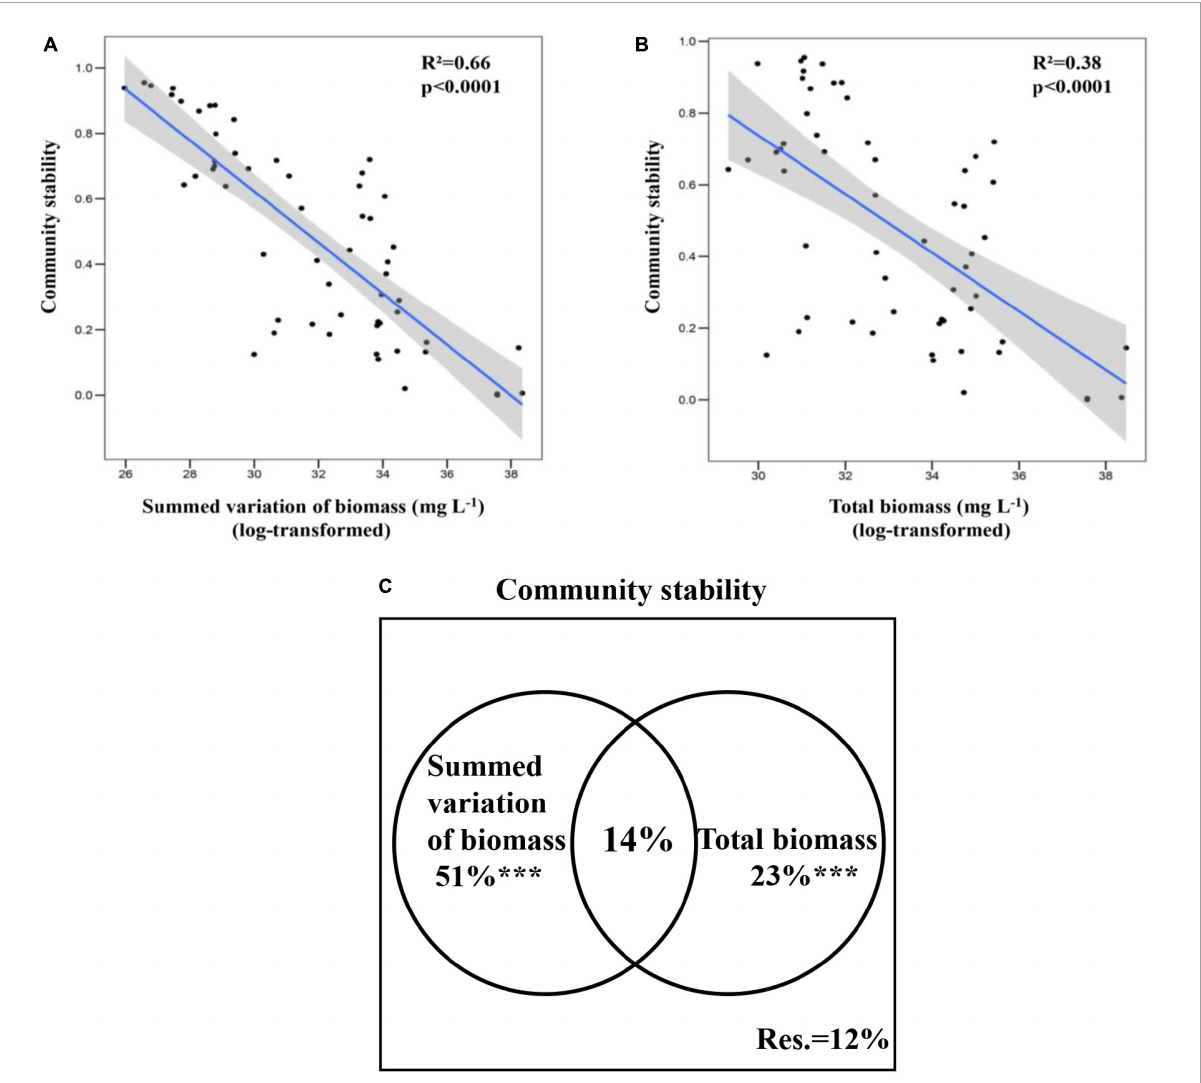
FIGURE3 Linear relationships between phytoplankton community stability (Bray–Curtis similarity) and summed variation of biomass (A) and total biomass (B) . (C) Shows the variance partitioning result for phytoplankton community stability. * p < 0.05, ** p < 0.01, and *** p < 0.001.